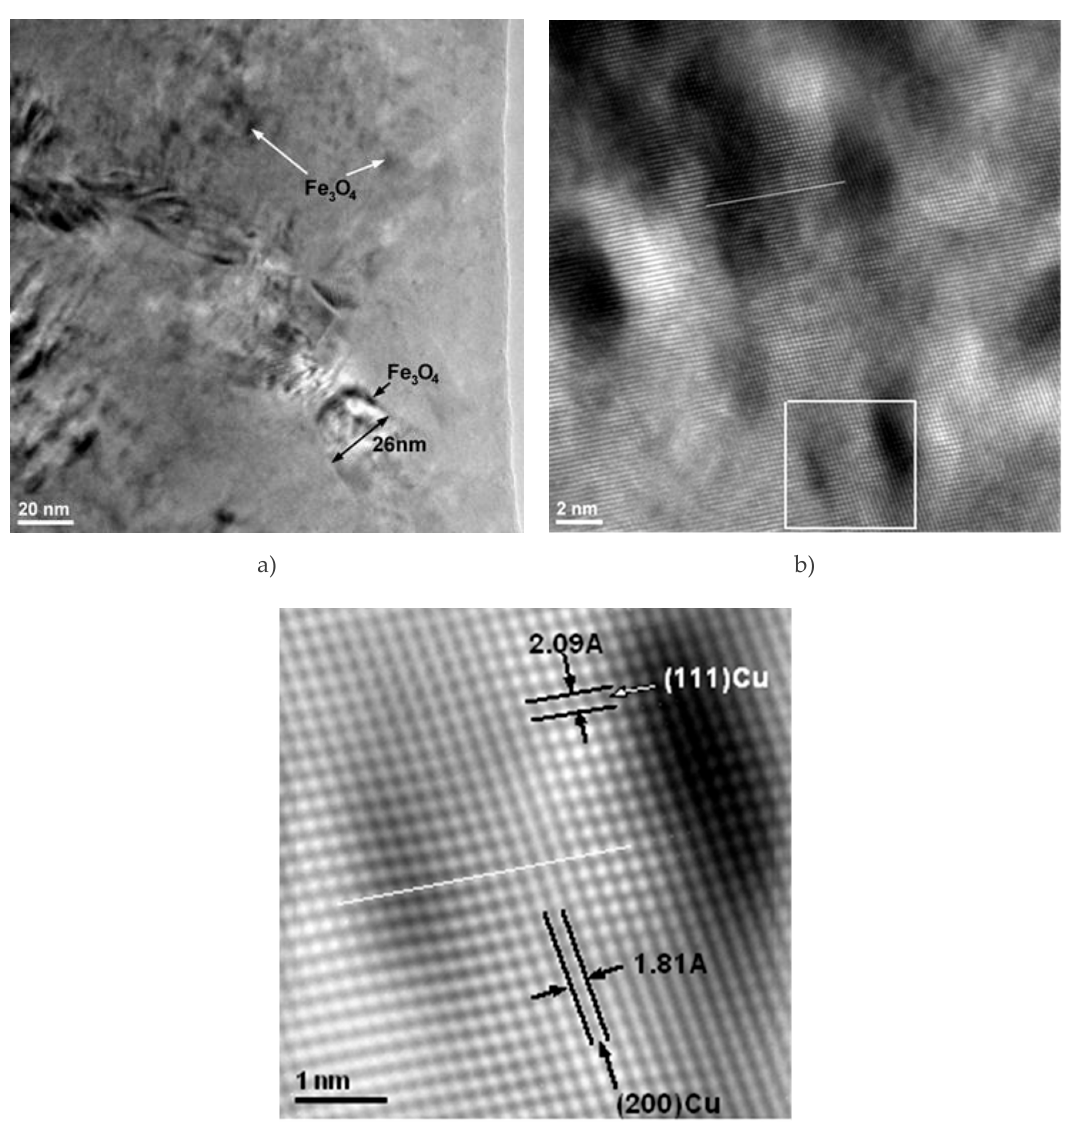
Figure 11. TEMBF images of the interface of Cu matrix and Fe3O4 nanoparticle ( a ); image showing an agglomeration of magnetite nanometer particles embedded in the Cu crystallite matrix ( b ); inverse Fourier Transformation of the image shown in the white square marked in ( b ) at the bottom of the image ( c